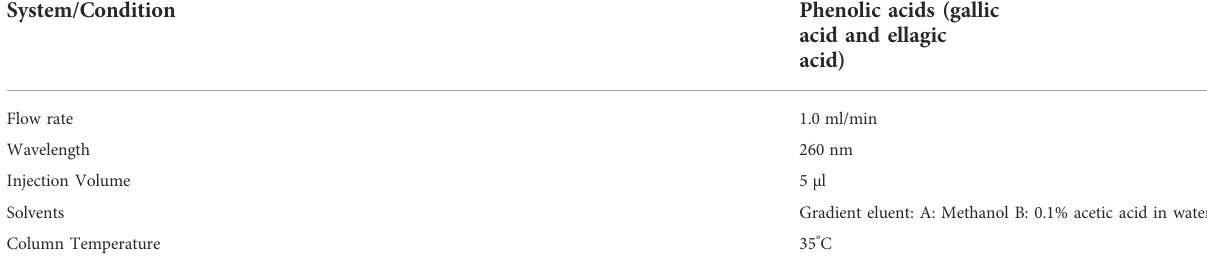
TABLE 1 The conditions of the HPLC system for analyzing phenolic acids.